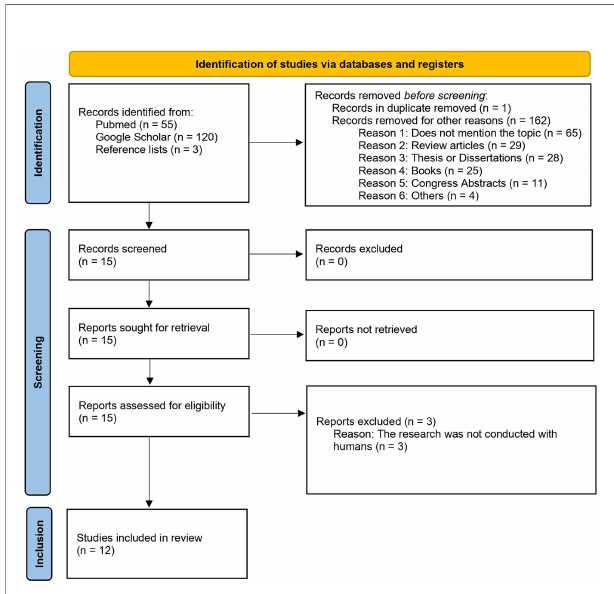
FIGURE 1 | Flowchart summarizing the process used to select the papers for this systematic review in three steps: identi fi cation, screening, and